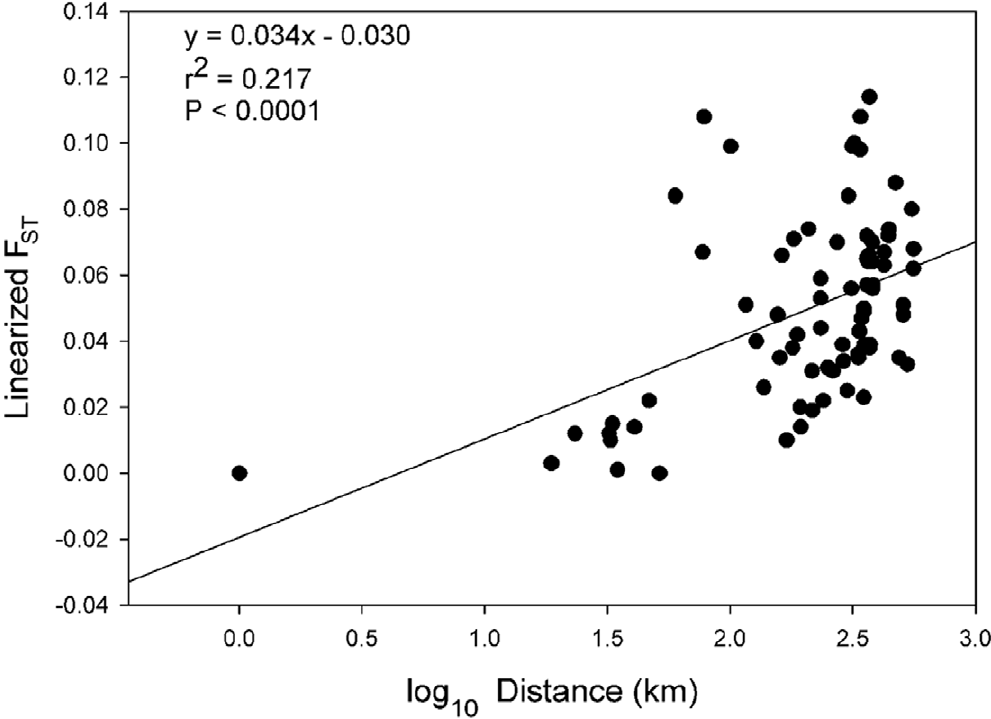
Figure 3. Graph of isolation by distance (IBD) results. Linearized F ST values (F ST /(1-F ST ) are regressed upon the log 10 linear distance (in km) between pairs of populations, showing a significant IBD effect (Mantel’s test P , 0.0001; r 2 =0.21).